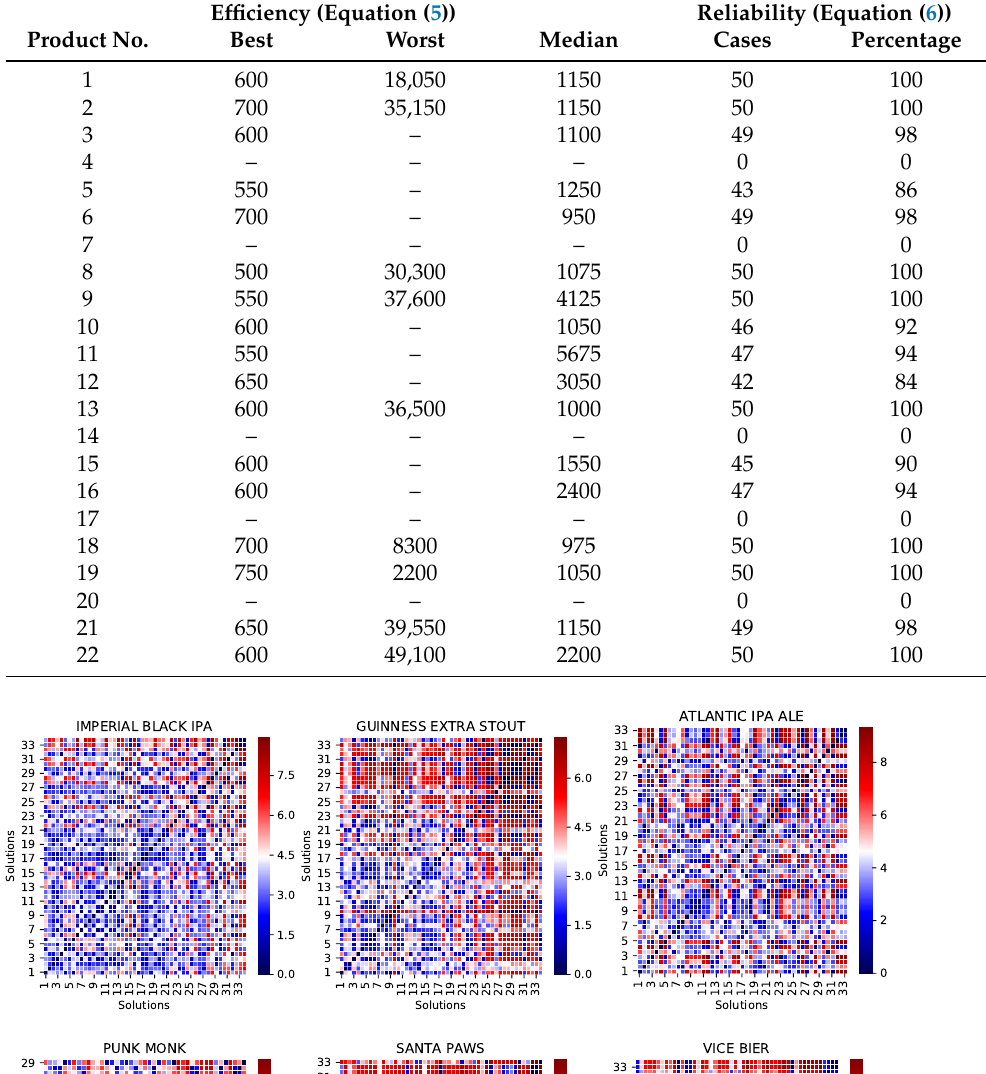
Table 4. Optimisation performance: efficiency and reliability.